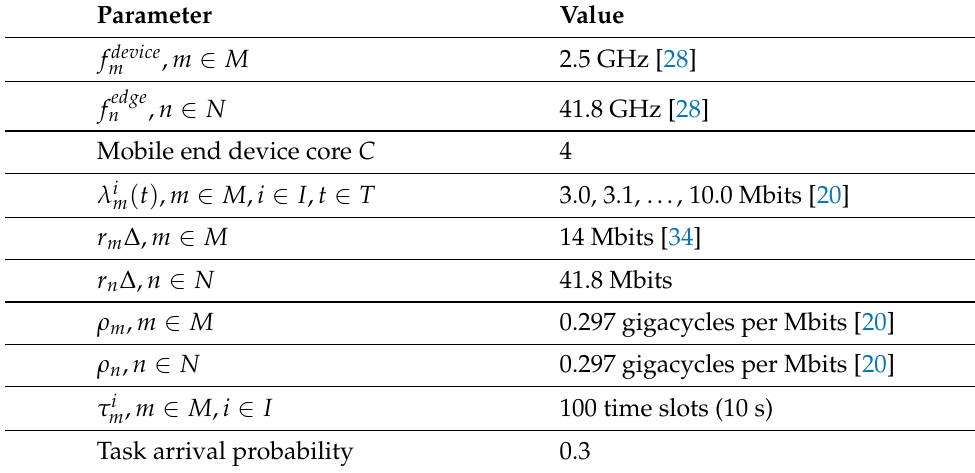
Table 1. Parameter